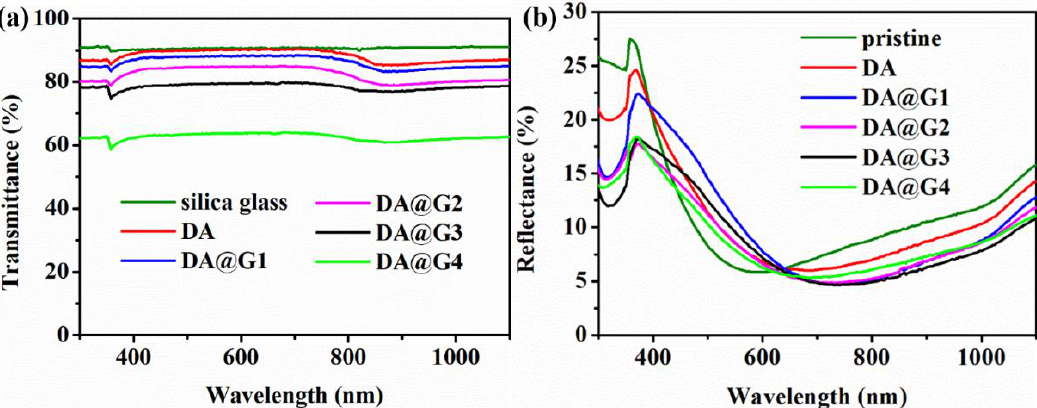
Figure 6. Transmittance and reflectance spectra. ( a ) Optical transmittance spectra of silica glass and DA@G spinning coated on silica glass and ( b ) reflectance spectra of PEDOT:PSS/Si (pristine), PEDOT:PSS/DA/Si (DA), and PEDOT:PSS/DA@G/Si.